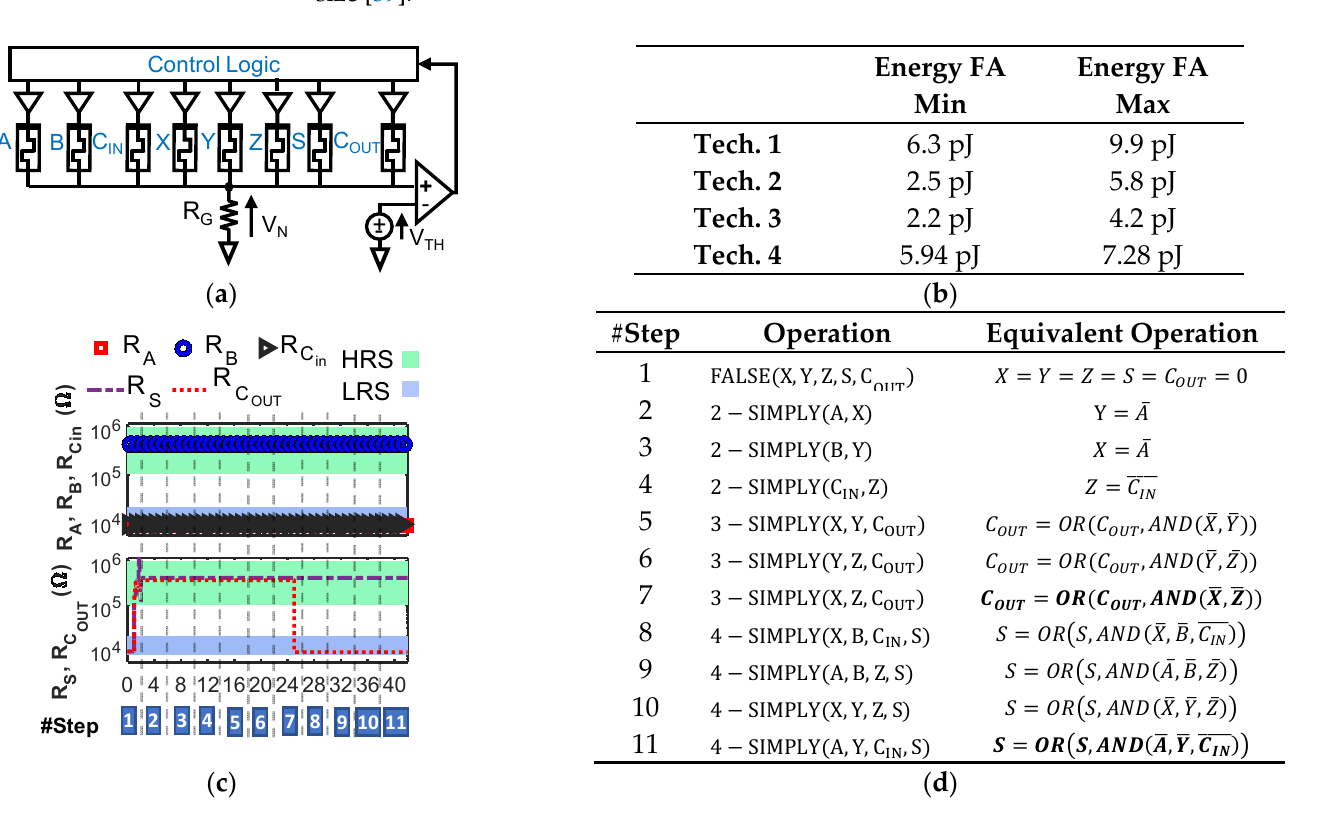
Figure 8. ( a ) Schematic of the proposed full adder (FA). A, B, C IN are input devices (bits), X, Y, Z additional RRAMs, S and C OUT output devices (bits). ( b ) FA total energy consumption for the 4 RRAM technologies used in this work, including variability and RTN, and considering all possible input bits’ combinations. ( c ) Resistance of devices A, B, C IN , S, and C OUT during the FA sequence of operations (corresponding steps are reported in ( d )) with A = 1, B = 0, C IN = 1 (technology 3). Input values keep unaltered. ( d ) List of operations required to compute the complete 1-bit full-addition.